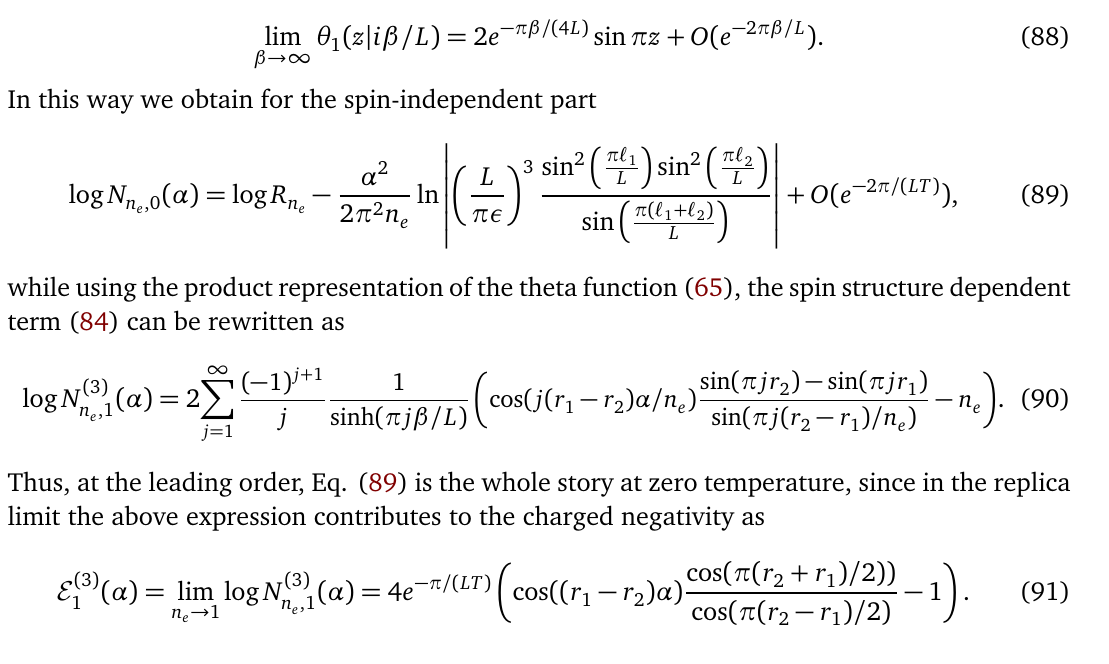
→ 1, given explicitly for the lattice model in Eq. (180) (and e = o